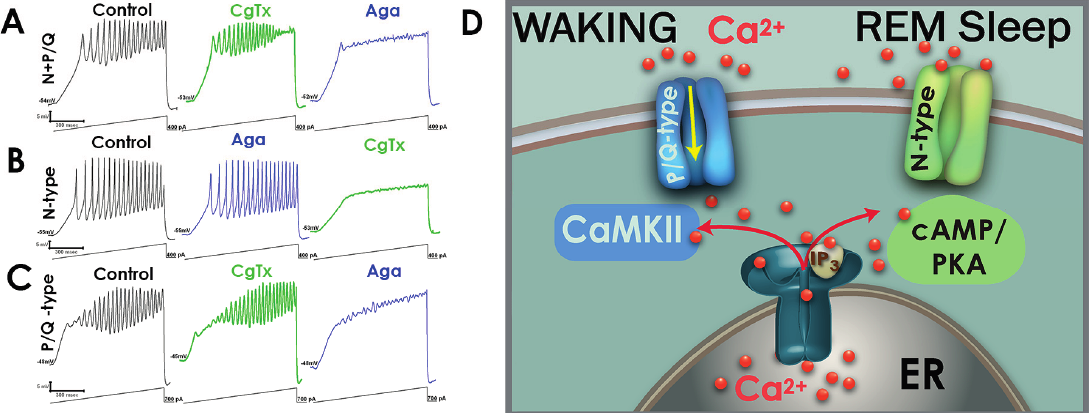
Figure 1. Calcium channel PPN cell types, functional and intracellular pathways. ( A )